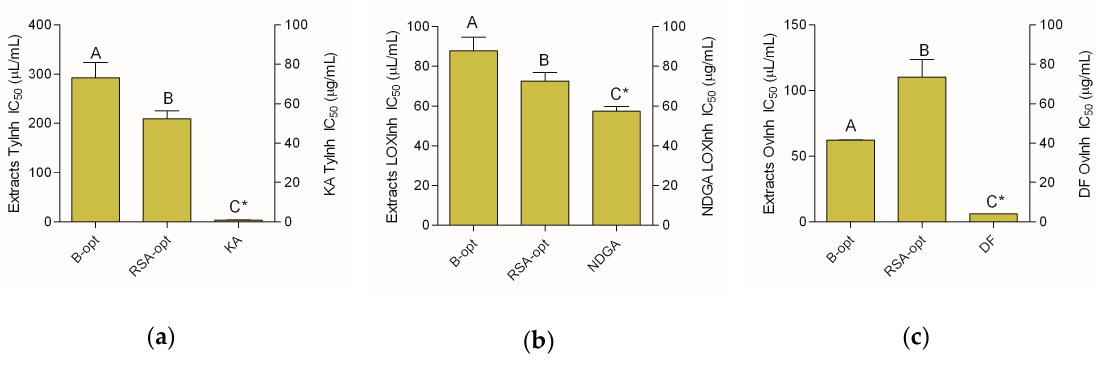
Figure 3. Cosmeceutical activity of the extracts and positive controls—kojic acid (KA), nordihydroguaiaretic acid (NDGA), and diclofenac (DF): ( a ) tyrosinase-inhibiting activity, ( b ) lipoxygenase (LOX)-inhibiting activity, and ( c ) coagulation-inhibiting activity. Different uppercase letters indicate statistical significance ( p < 0.05). Asterisks (*) indicate that the IC 50 unit is placed on the right y -axis.